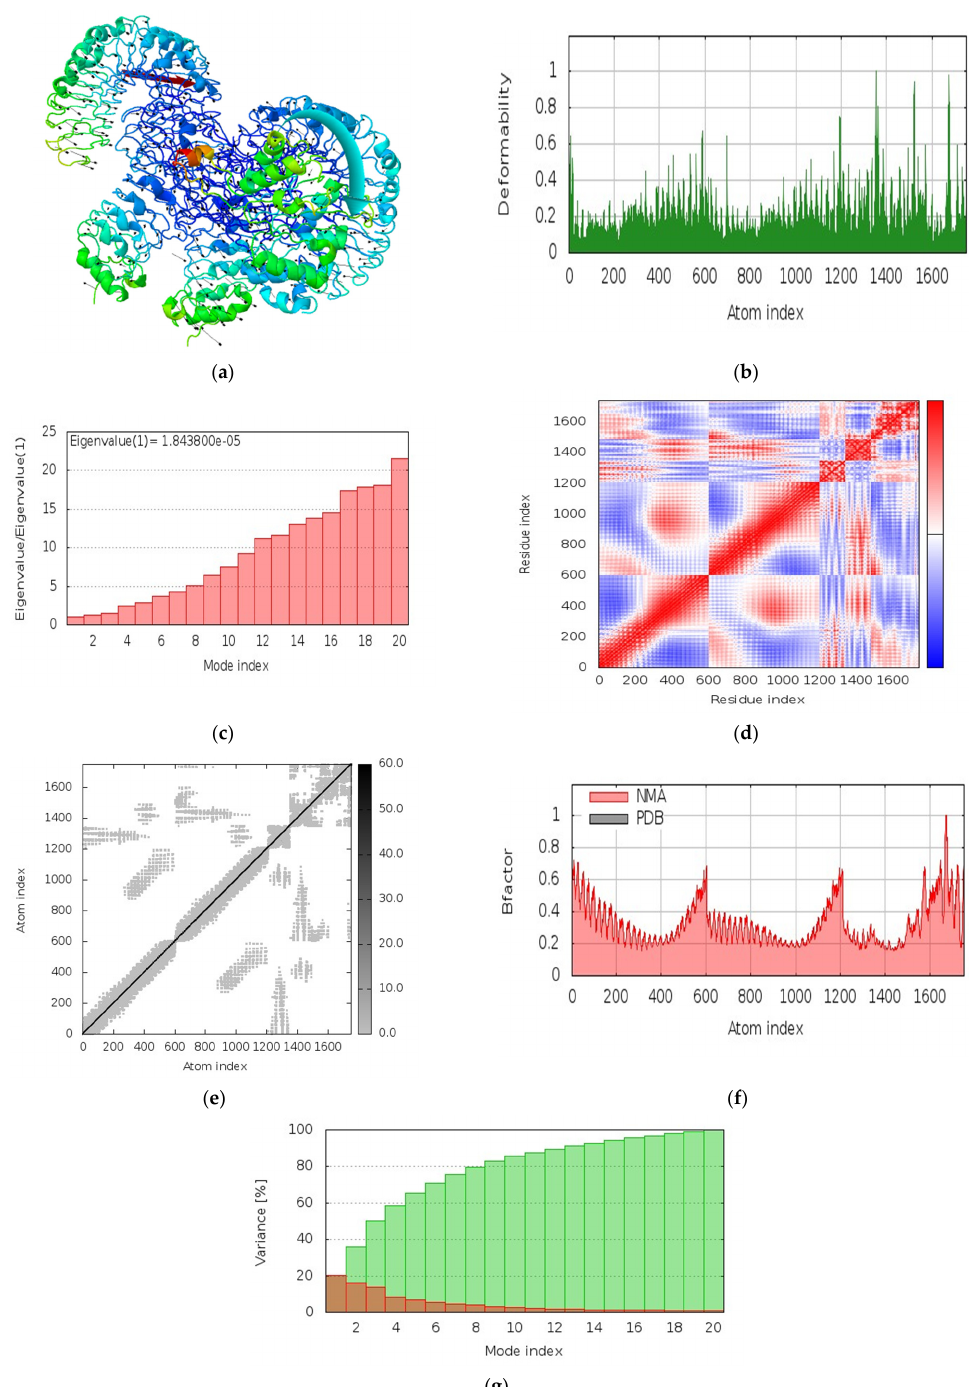
Figure 9. Vaccine–TLR4 complex molecular dynamics simulation, showing ( a ) spin prediction of the ligand–receptor interaction; ( b ) deformability; ( c ) eigenvalue; ( d ) covariance matrix depicting the coupling between pairs of residues (red), uncorrelated (white), or anti-correlated (blue) motions; ( e ) elastic network analysis defining which pairs of atoms are connected by springs; ( f ) variance; and ( g ) B-factor.